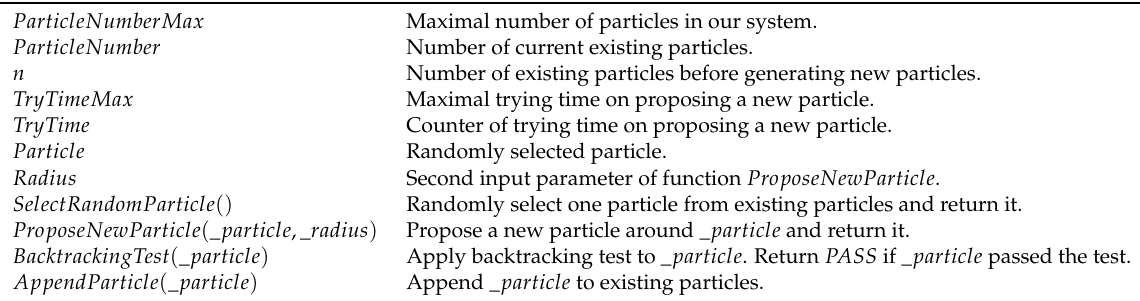
Table 2. Definition of variables and functions in Algorithm